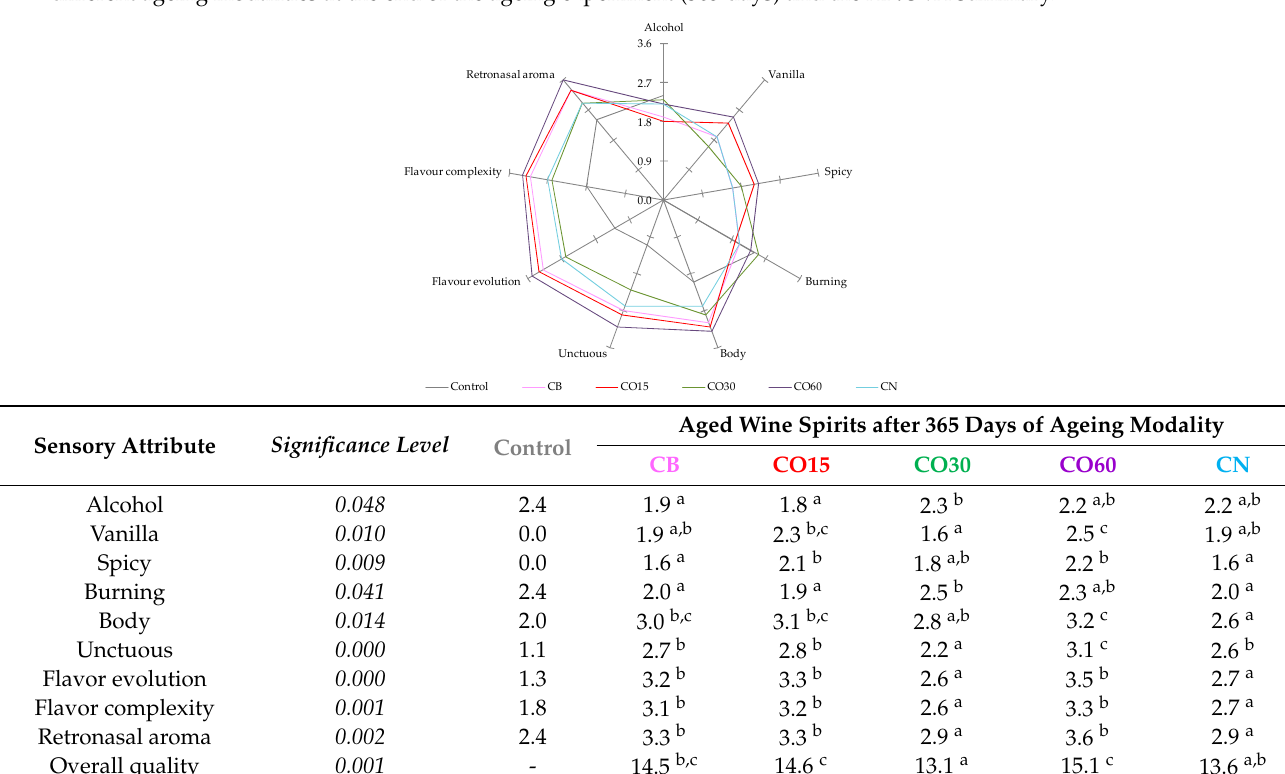
Table 3. Sensory attributes intensity (average values) determined by the sensory panel in the wine spirits sampled from